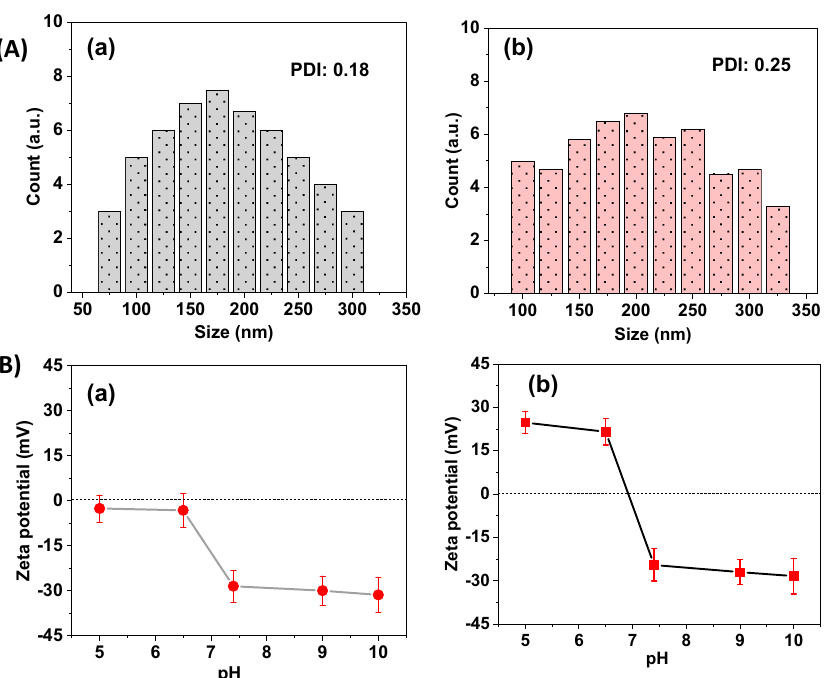
Figure 3. ( A ) Particle size distribution; and ( B ) Zeta potential analysis of ( a ) MS@GPTMS NPs and ( b ) MS@PNIPAm-PAAm NPs, respectively.